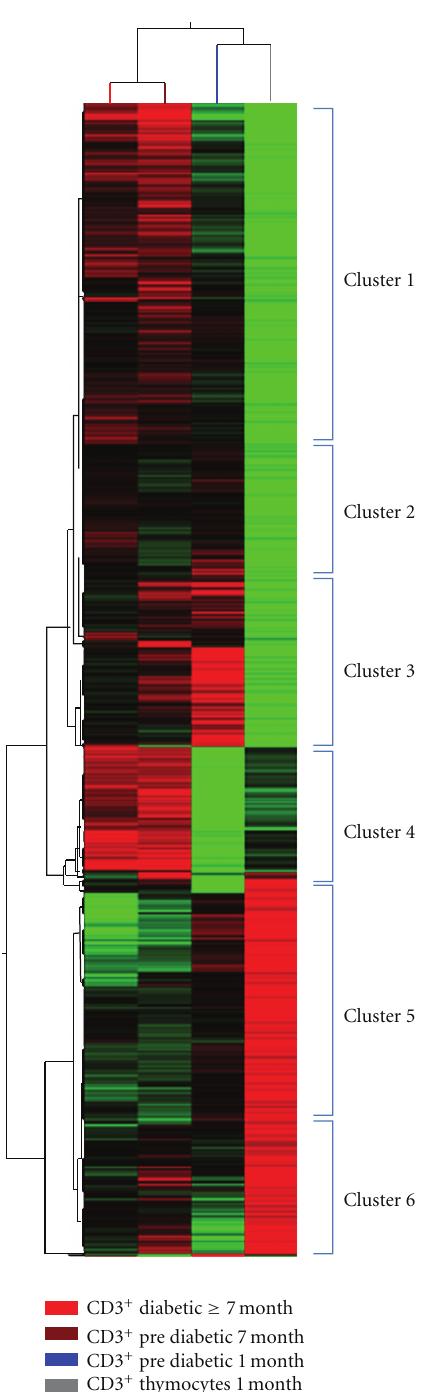
Figure 3: Hierarchical clustering of thymocytes and peripheral CD3 + lymphocytes of nonobese diabetic (NOD) mice based on microarray gene expression profiling. Dendrograms and heat maps were obtained using the Cluster-Tree View program within the GeneSpring GX (Agilent) platform. Red = upregulation, green = downregulation, and black = unmodulated (Pearson correlation metrics, 75 percentile). The 2,771 di ff erentially expressed genes were divided in six clusters (clusters 1 to 6) according to their relative expression levels and